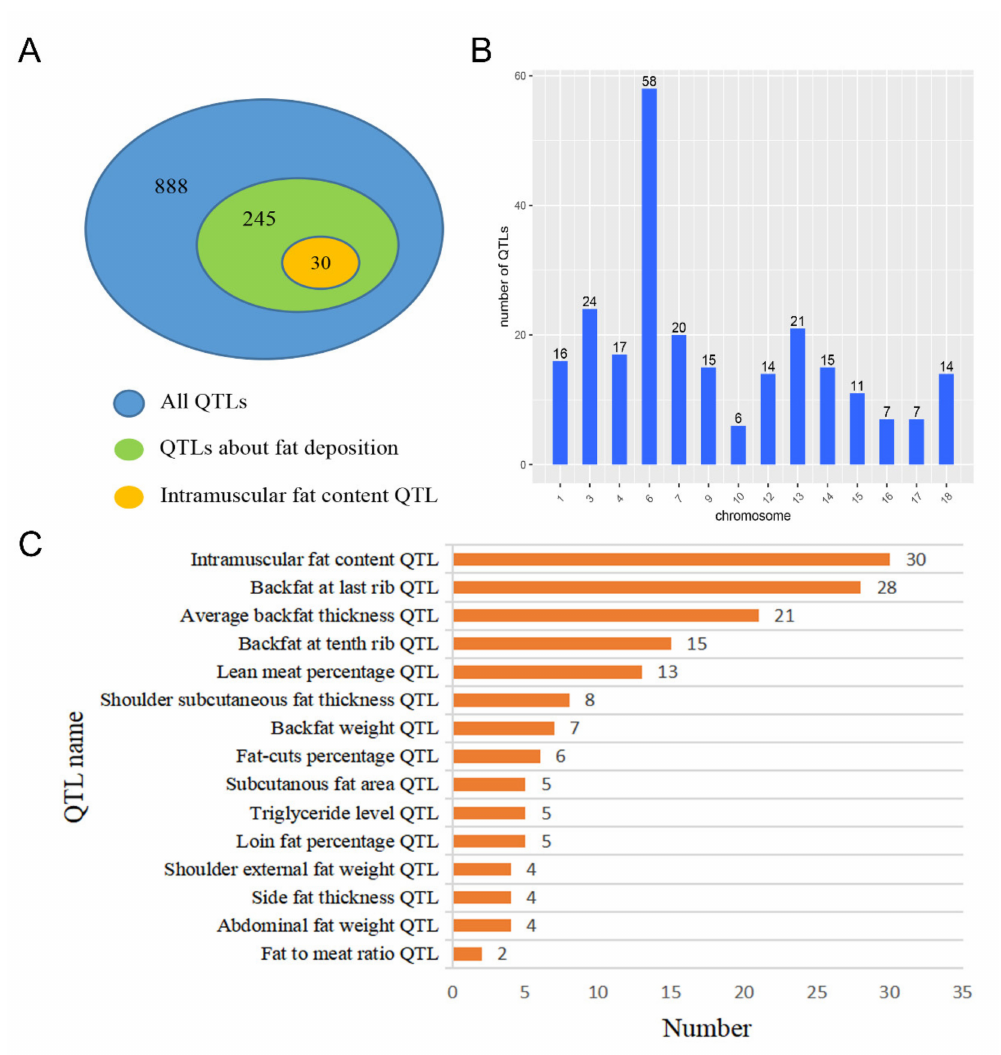
Figure 4. Quantitative trait locus analysis of DE lincRNAs. ( A ) The number distribution of quantitative trait loci (QTLs) associated with fat deposition and all QTLs; ( B ) the chromosome distribution of QTLs associated with fat deposition; ( C ) the number of QTLs associated with fat